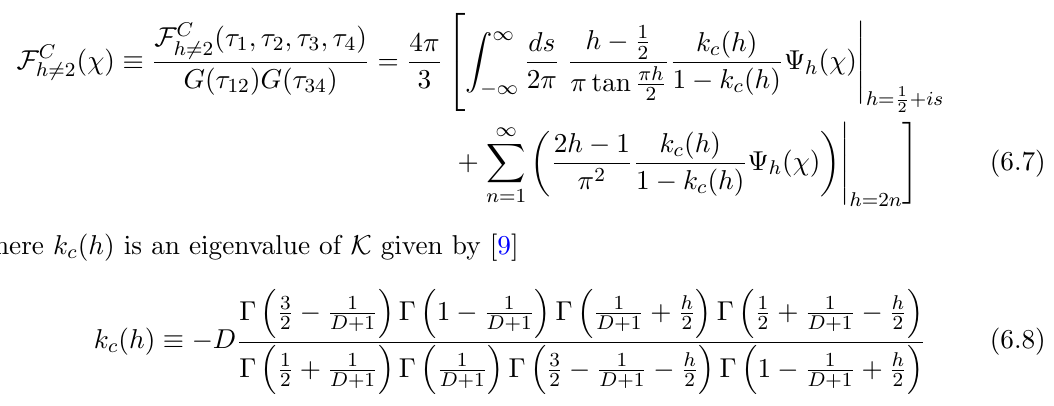
Figure 26. Leading and sub-leading diagrams in Pillow channel in rank- D tensor